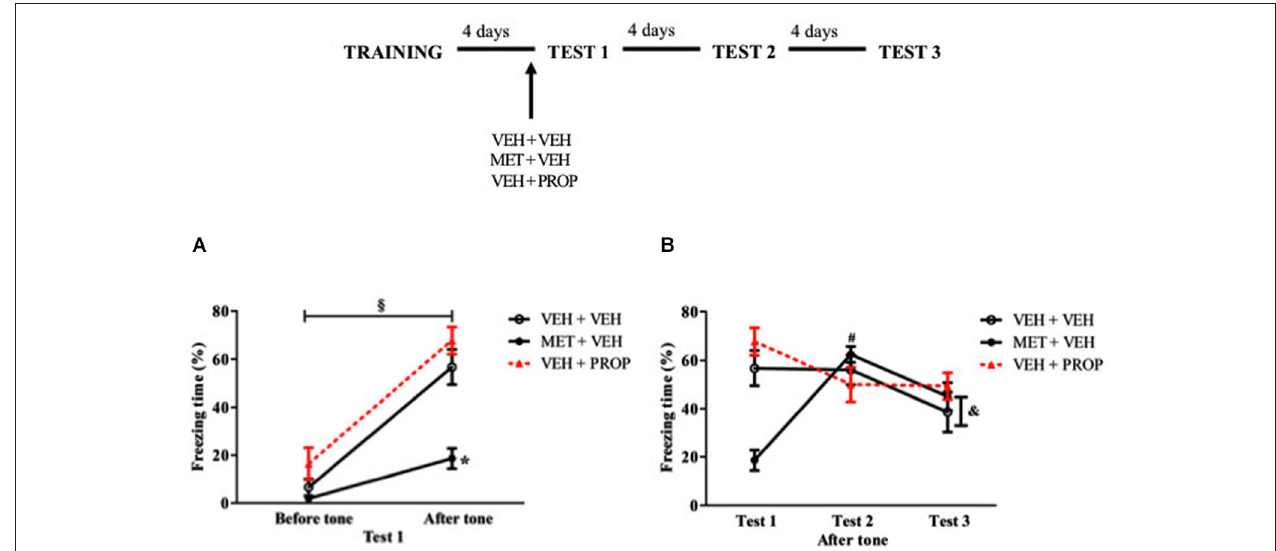
( n = 10); MET + VEH = metyrapone group ( n = 8); VEH + PROP = propranolol group ( n = 9). * P < 0.05, compared to control group; § P < 0.05, comparing pre and post-tone moment. # P < 0.05, compared to Test 1, for all groups; & P < 0.05, compared to Test 2, only for MET + VEH and VEH + VEH